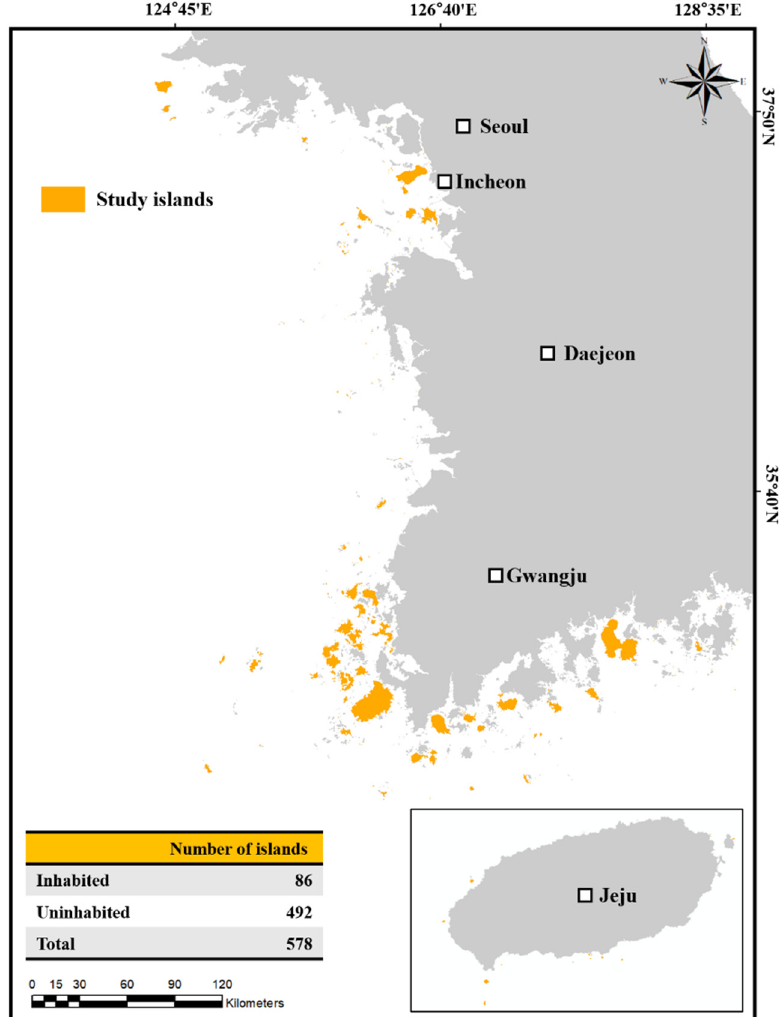
Figure 1. The location of the study islands on the western, southern, and Jeju Island seas, South